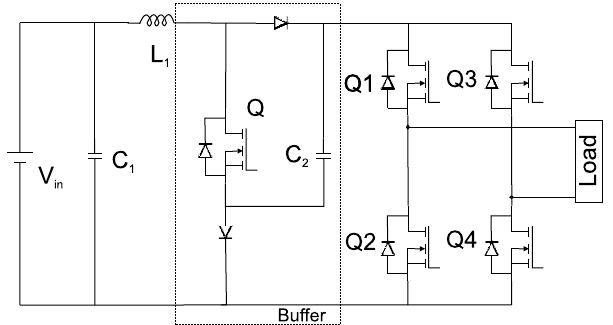
Figure 15. Configuration proposed in